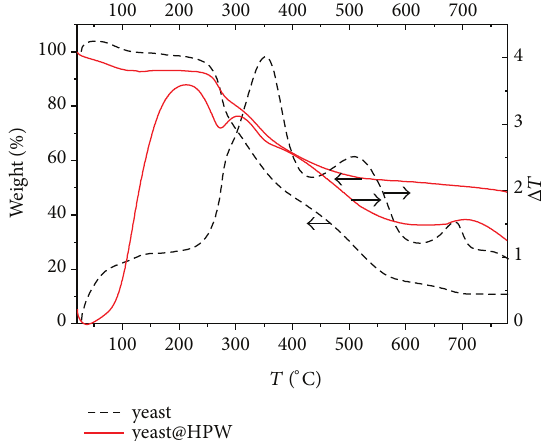
Figure 4: TG and DTA curves of yeast and HPW@yeast samples.